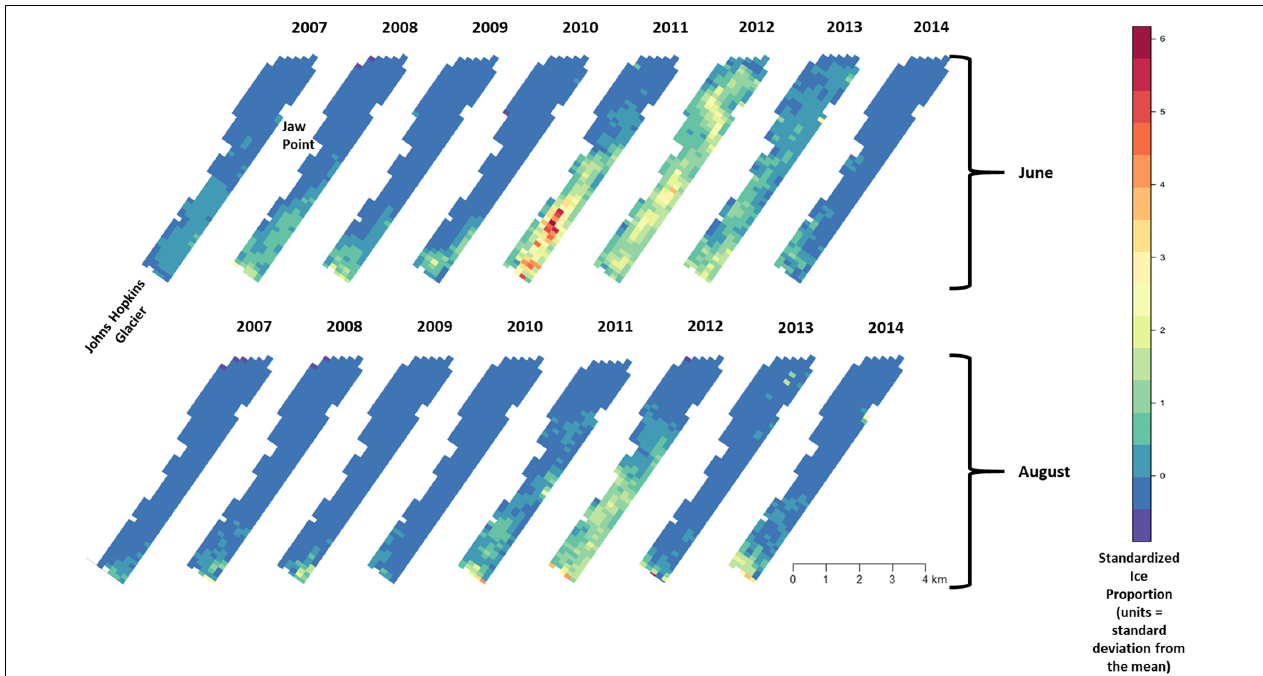
FIGURE 5 | Median of posterior distribution for µ (expected value of z-standardized ice proportion). Ice proportion in Johns Hopkins Inlet in Glacier Bay National Park in southeastern Alaska during the pupping period in June (top panel) and during the molting period in August (lower panel) from 2007 to 2014. Grid cell size is 200 m × 300